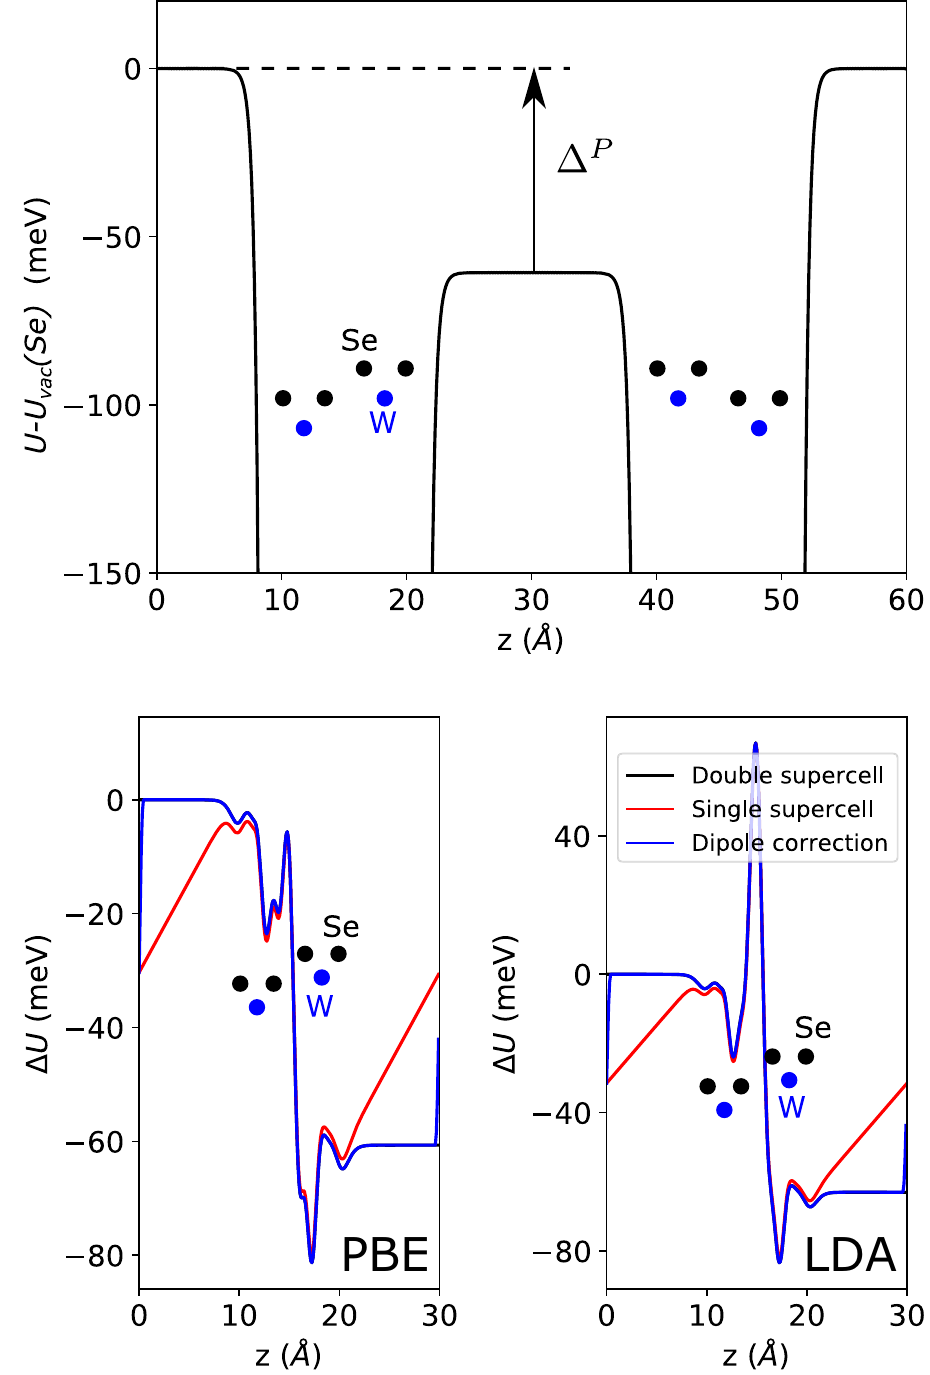
Figure 2. Upper panel: Out-of-plane dependence of in-plane averaged electron potential energy of XM ′ bilayer WSe 2 (including ionic and Hartree contributions), relative to the vacuum potential on the Se side of the vertical W–Se pair, U vac ( Se ) , which is set to 0 eV. The calculation is for a double-bilayer supercell, with the structure shown as a schematic inset. The charge transfer between the layers gives each bilayer a finite dipole P moment, with a consequent difference ( (cid:31) ) between the vacuum levels on either side of a bilayer. Left-hand lower panel: potentials with isolated monolayer contributions subtracted, to better show the potential drop and other features. Three calculation methods are shown: black line—first 30 Å of the upper panel, red line—using only a single bilayer supercell, showing how the mismatched vacuum levels give a finite displacement field as necessitated by the periodic boundary conditions, blue line—a single bilayer supercell, but with a compensating dipole correction applied. The right-hand lower panel shows the same quantities, calculated using the LDA for comparison. 0 meV is set to the double-supercell vacuum level on the Se side of the vertical W–Se